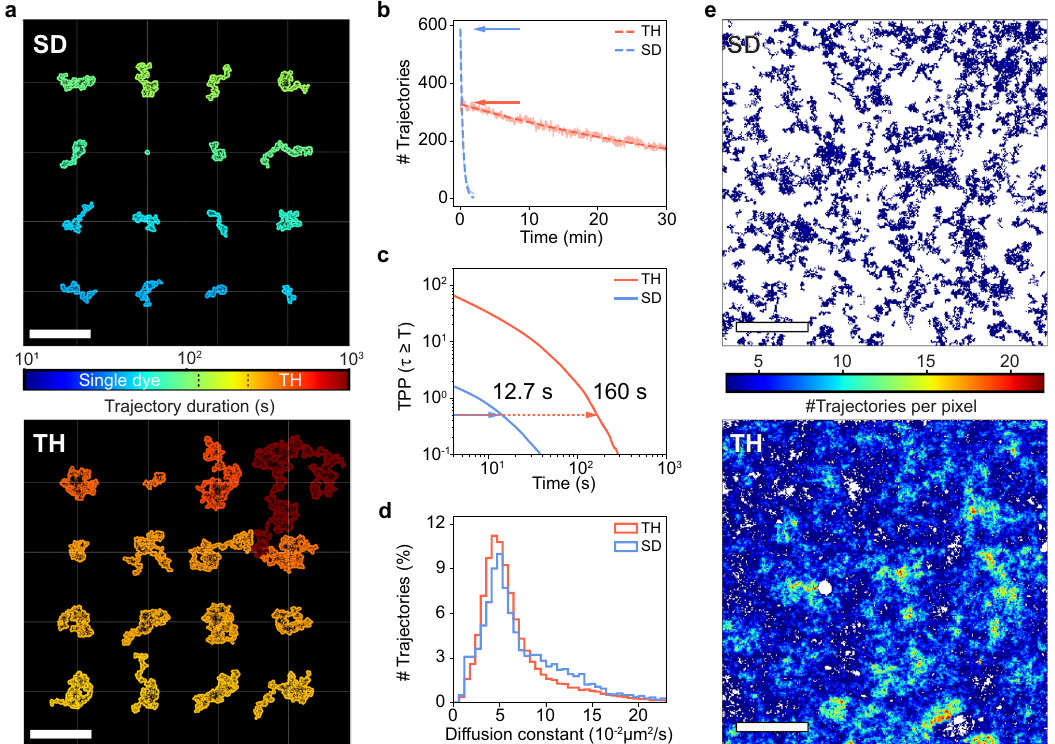
Fig. 2 Probing 2D diffusion of DNA origami on lipid membranes. a The 16 trajectories of longest duration of both SD origami (top) and TH origami (bottom) fl oating on an SLB. The trajectories where shifted according to their mean position indicated by the joints of the white dashed lines and were color-coded by duration for better visibility. b Number of trajectories per frame for SD origami (solid blue) and TH origami (solid orange). The curves were fi tted by an exponential decay function (dashed). The arrows indicate the initial track number ( (cid:3) number of Origami) M within the FOV. c Average number of tracks per Origami TPP ð τ n (cid:5) T Þ as obtained by normalization to the initial track number M (arrows in b , see Supplementary Note 2). d Diffusion constants as obtained by linear iterative fi tting of the individual MSD curves. Histograms represent the total distribution of three different samples imaged under three different irradiances. Only trajectories with more than 20 localizations were included giving a total of n (cid:3) 61.000 trajectories for the TH origami and n (cid:3) 9.000 trajectories for the SD origami. e Number of unique trajectories per 2 × 2 binned pixel (complete FOV). For each binned pixel we counted the number of unique trajectories passing through it during the entire measurement (i.e., a unique trajectory having at least one localization within the pixel boundaries increases its count by one). The TH origami allowed an almost complete mapping of the SLB (bottom) in contrast to only sparse sampling for the SD origami (top). White areas indicate that no trajectory passed these pixels over the complete measurement time. SLB tracking experiments were repeated at least three times for TH origami and at least nine times for SD origami yielding similar results (compare also varying irradiances in Supplementary Figs. 8 and 9). Scale bars, 10 μ m in ( a ), 20 μ m in ( e